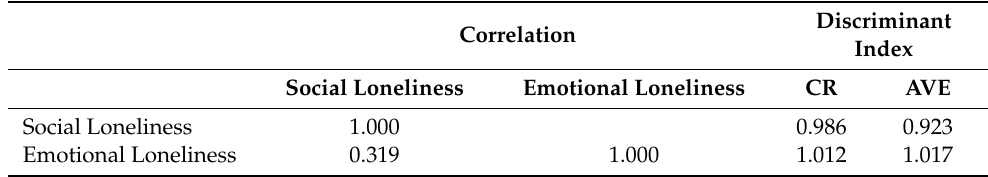
Table 6. Discriminant validity of the DJGLS in the Mexican